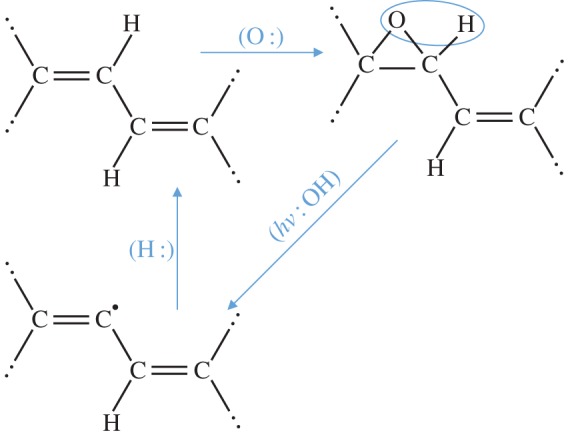
A formation pathway for nanoparticle surface epoxide groups and the catalytic formation and liberation of OH radicals following UV photolysis in the tenuous ISM. Note that in this and the following three figures the species denoted with double-dotted bonds are assumed to be bonded to the contiguous structure of the nanoparticle.